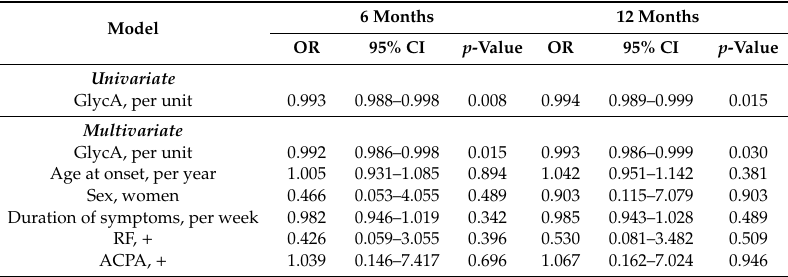
Table 4. GlycA as predictor of treatment outcomes in early